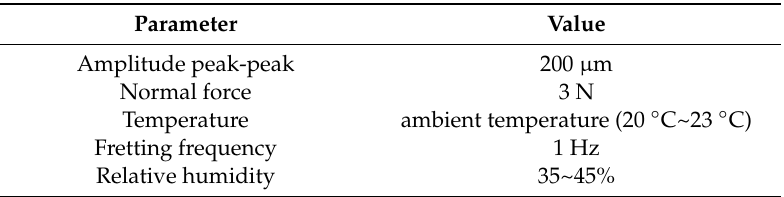
Figure 3. Wear and fretting corrosion test device and samples. Table 1. Test parameters.